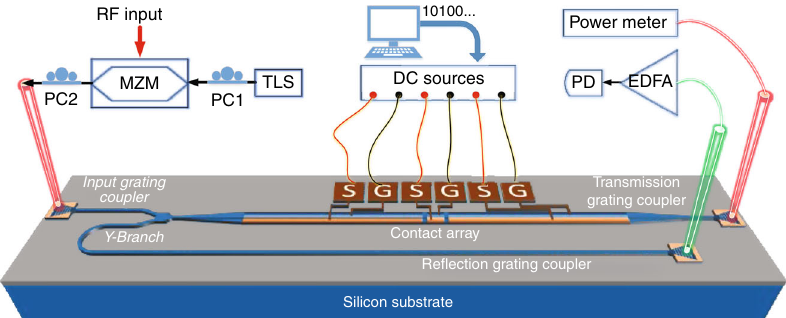
Fig. 4 Schematic view of a programmable microwave signal processor. The experimental set-up consists of a tunable laser source (TLS), a polarization controller (PC), a Mach-Zehnder modulator (MZM), an erbium-doped fi ber ampli fi er (EDFA), and a